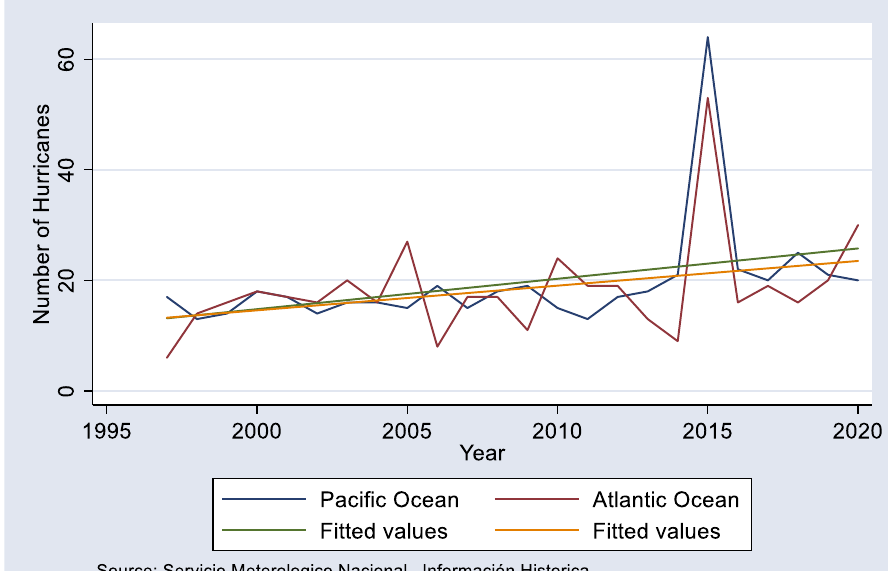
Figure 1. Hurricanes in the Mexican seas and shores.